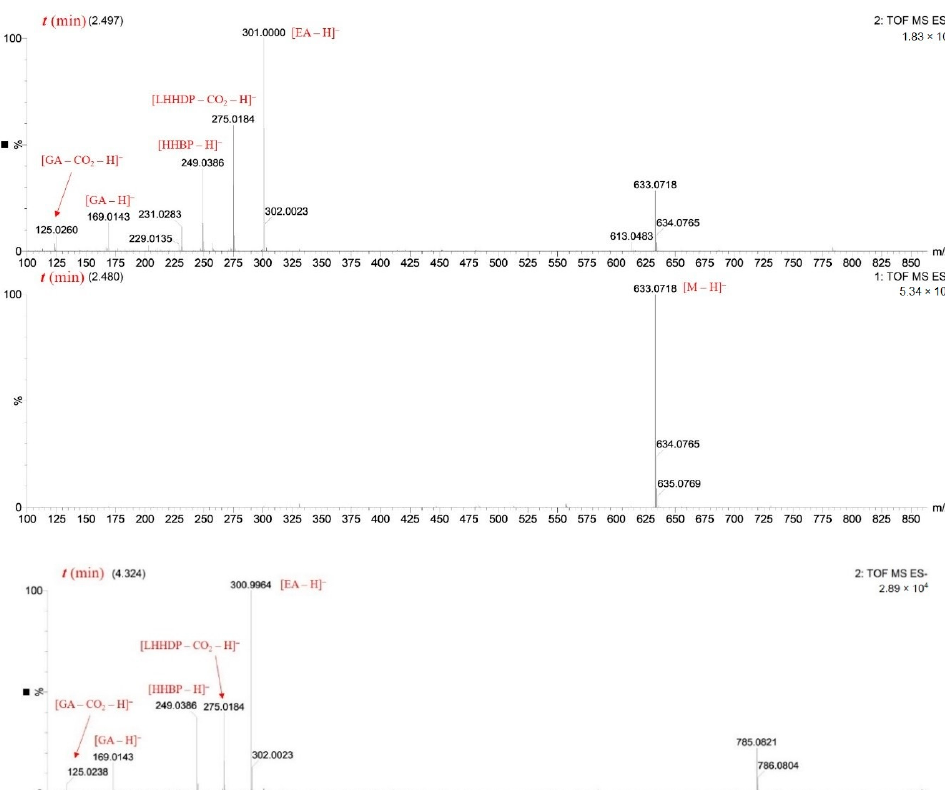
Figure 3. MS spectra of selected ellagitannins and products of their fragmentation (generated depsides). Abbreviations: GA, gallic acid; EA, ellagic acid; LHHDP, decarboxylated hexahydroxydiphenic acid monolactone; HHBP, 2,2’,3,3’,4,4’-hexahydroxybiphenyl; VTL, valoneic acid trilactone.